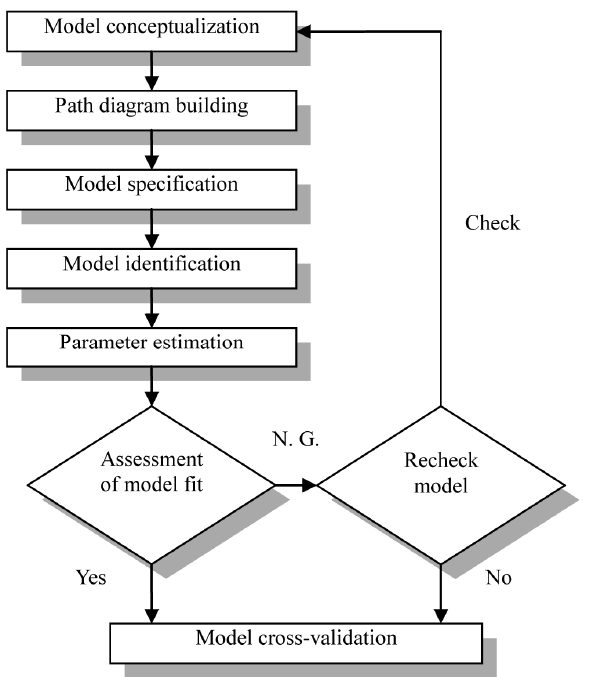
Fig. 2. Procedure of performing SEM analysis